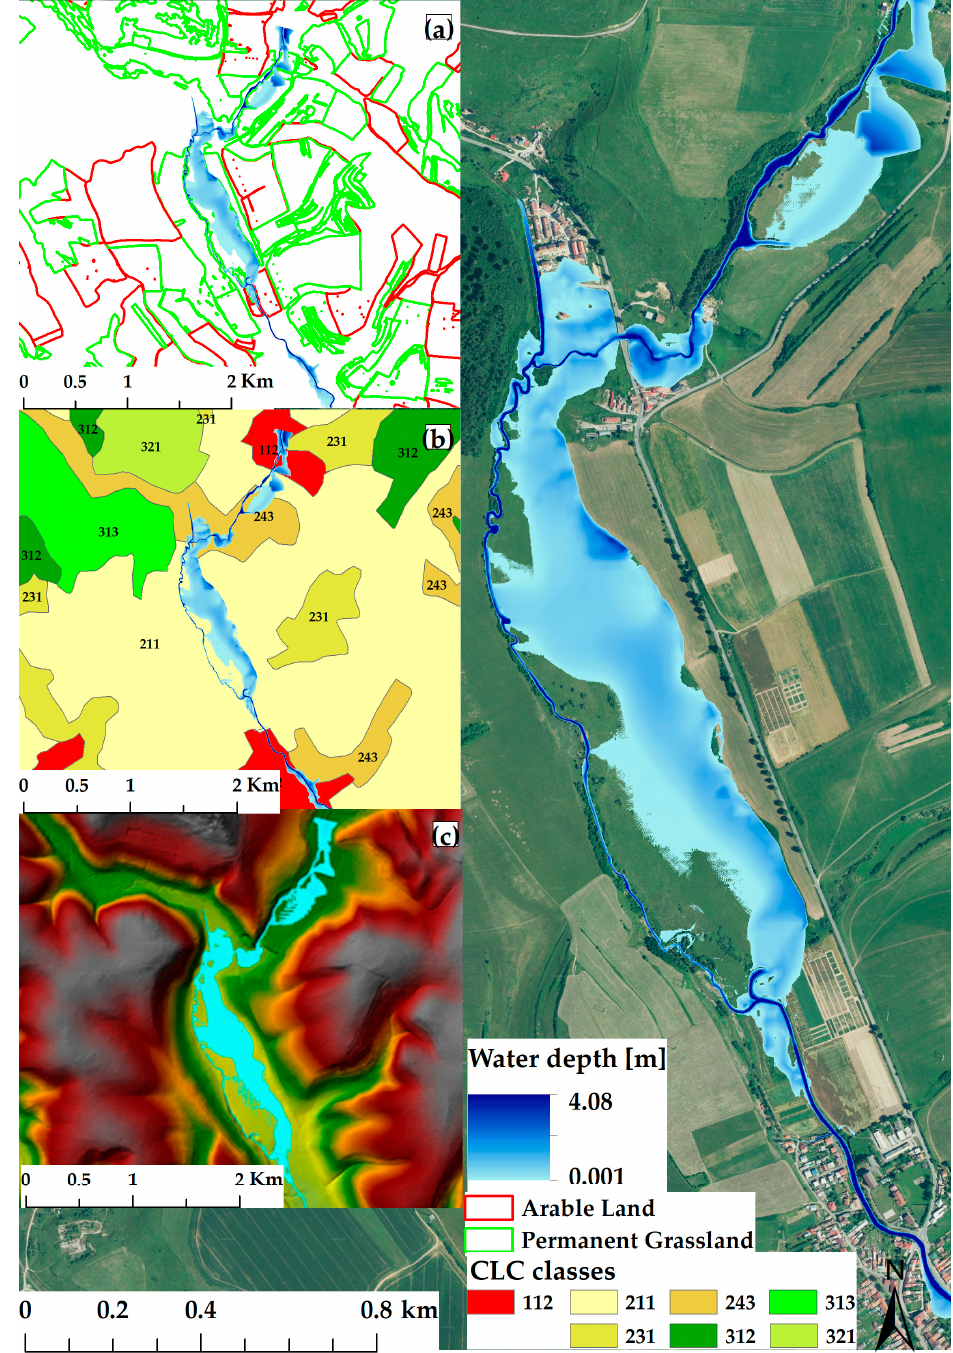
Figure 10. Visualization of flood risk evaluation results: ( a ) range of the flood polygon on the base map of LPIS 2018; ( b ) range of the flood polygon on the base map of CLC 2018; ( c ) flood simulation using the Ras Mapper interface on the base map of DTM.